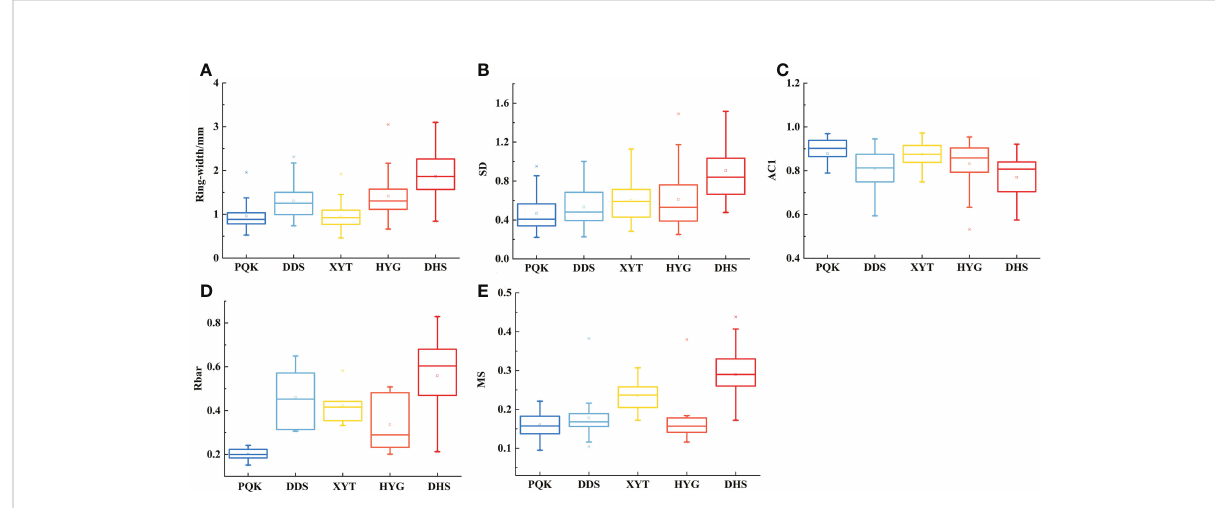
FIGURE 5 Comparison of statistics of the raw tree-ring measurements at the fi ve sampling